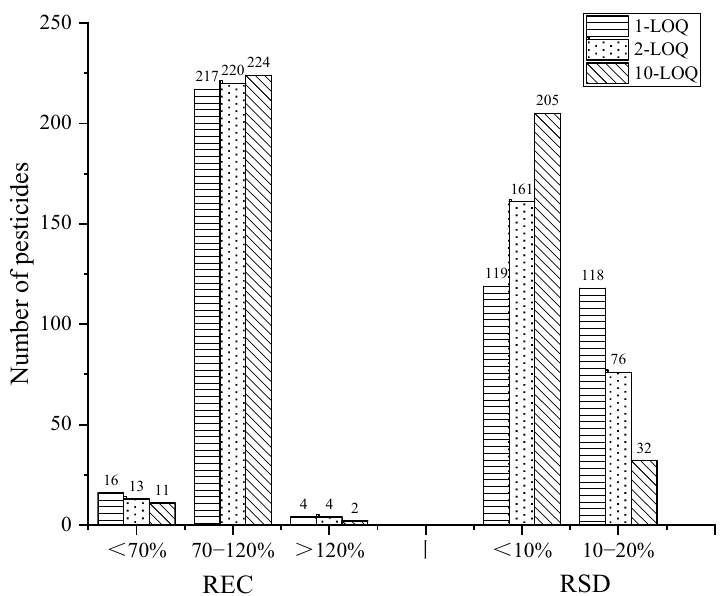
Figure 8. The recovery and RSD of the target pesticides at three spiked levels.